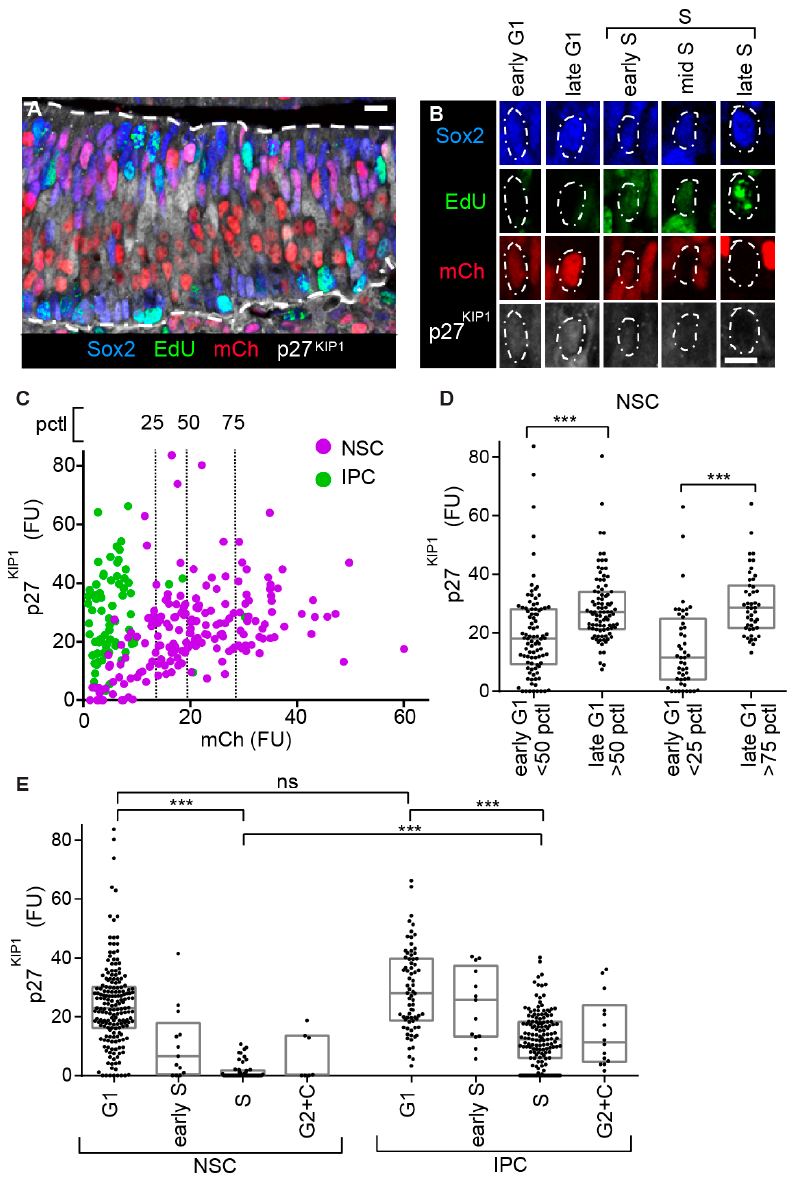
Figure 4. Examination of p27 KIP1 expression by precursor type and cell cycle phase. ( A ) Labelling of E13.5 OE with a combination of mCherry-hCdt1 (30 / 120), a 30 min pulse of intraperitoneal EdU injection, anti-Sox2, and anti-p27 KIP1 . ( B ) Division of NSC G1 and S phases using the labelling combination shown in panel ( A ). ( C ) A comparison between mCherry-hCdt1 (30 / 120) and p27 KIP1 levels (the mCherry-hCdt1 (30 / 120)-positive, EdU-negative cells were examined). The vertical dashed lines show the 25th, median, and 75th percentiles (pctl) of mCherry-hCdt1 (30 / 120) levels in the NSC population. Pearson correlation analysis of mCherry-hCdt1 and p27 KIP1 levels in the NSCs: r = 0.40, p < 0.0001 (NSCs n = 185, IPCs n = 72). ( D ) Box plots showing comparison of p27 KIP1 levels for early and late phases as defined by the staining levels of mCherry-hCdt1 (30 / 120). We compare the population of cells above and with that below the 50th percentile (pctl) for mCherry-hCdt1 (30 / 120) levels (n = 92, 93). Similarly, above and below the 75th and 25th pctls, respectively (n = 47, 48). FU—average intensity in fluorescence units. ( E ) Box plots showing p27 KIP1 levels by cell cycle phase for NSCs and IPCs (n = 185, 13, 50, 7, 72, 13, 149, 14). In plotting these graphs, we combine cells in G2 with the small percentage of cells (2% in NSCs and 5% in IPCs) that are an undefined colorless state (labelled as C). ( D , E ) Kruskal–Wallis test with Dunn (cid:48) s multiple comparisons. ns (not significant), * ( p ≤ 0.05), ** ( p ≤ 0.01), *** ( p ≤ 0.001); scale bars = 10 µ